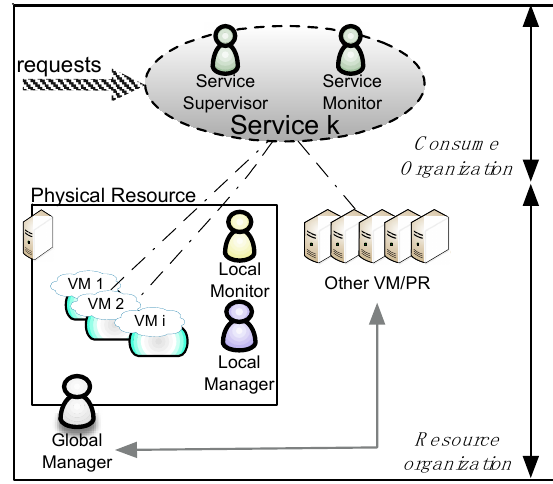
Figure 1. Distribution of agents on the cloud computing platform.